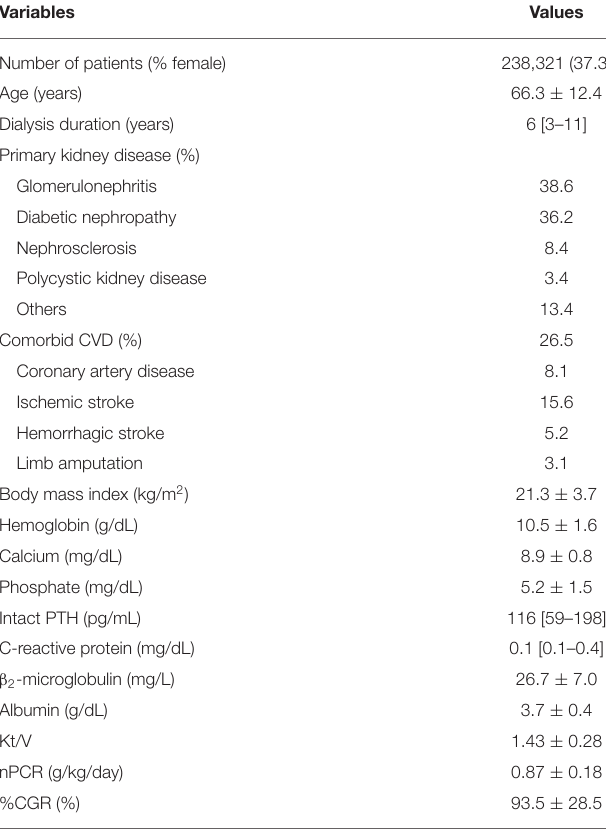
TABLE 1 | Demographic, clinical, and laboratory values at baseline for the 238,321 hemodialysis patients included in this study. Variables Values